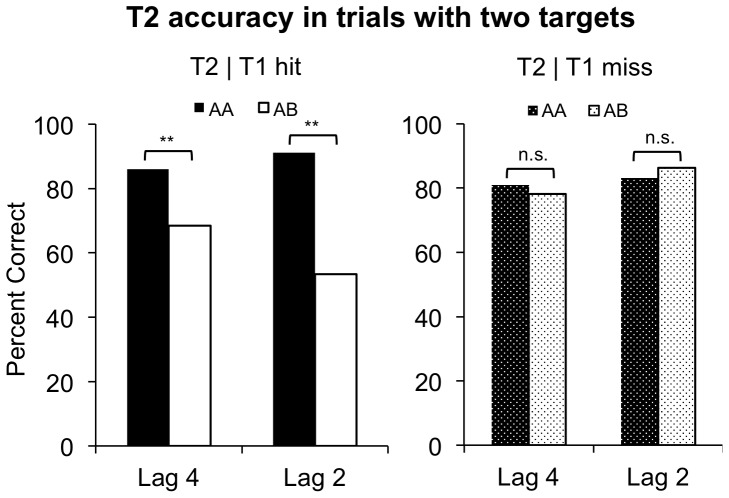
T2 accuracy in trials with two targets.The left panel plots T2 accuracy given that T1 was identified. Consistent with our prior findings of set-specific capture, T2 accuracy was lower in AB than in AA trials at both Lag 2 and Lag 4. A double asterisk indicates a p-value less than 0.0005. The right panel plots T2 accuracy given that T1 was missed or reported incorrectly. In these trials, T2 accuracy did not vary with T1’s color.